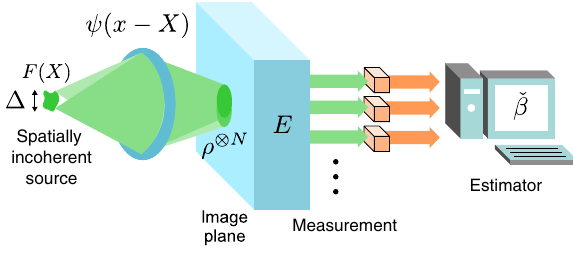
FIG. 9. A far-field incoherent optical imaging